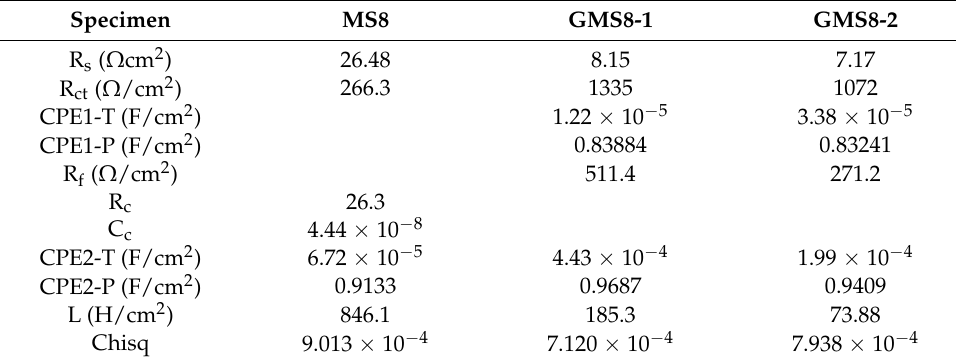
Table 2. Parameters of the circuit model fitted from the Nyquist plots of the specimens in PBS at 37 ◦